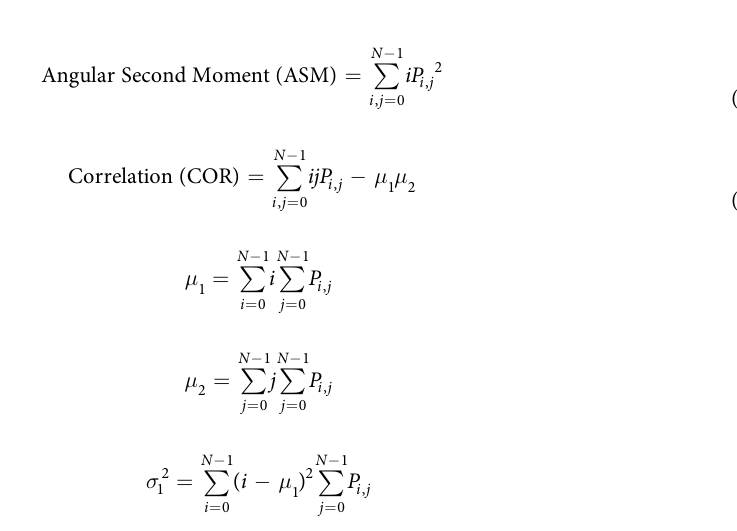
HOM is a measurement of lack of variability or the amount of local similarity in the scene. High HOM values suggest small grey tone differences in pair elements. CON is a measure of the amount of local variation in pixel values between neighbouring pixels. It is high for regions exhibiting large local variations and is the opposite of HOM. DIS is similar to CON and inversely related to HOM. It is high when the local region has a high CON. ENT is a measure of the degree of disorder in an image. ENT is larger when the image is texturally non-uniform or heterogeneous. It is the opposite of ASM. VAR is high when there is a large standard deviation of grey level in the local region. ASM and uniformity are measures of textural uniformity and pixel pair repetition, respectively. They are high when the GLCM is locally homogenous; they are similar to HOM. COR is a measure of grey level linear dependencies in the image. High COR values denote a linear relationship between the grey levels of pixel pairs. Figure 10 shows subsets of seven texture features. Statistical analysis. Empirical relationships between texture parameters and LAI were investigated by car- rying out linear analyses using LAI as the independent variable and the texture parameter as the dependent varia- ble. Different texture features were extracted for all field plots using an area of interest mask (AOI) of 20 m × 20 m. The average of AOI texture values was used to establish the simple linear models. Adjusted r 2 values were com- puted based on linear relationships between the two variables, as required 34 . All statistical analyses were carried out using the SAS software package (version 8.0) for Windows.